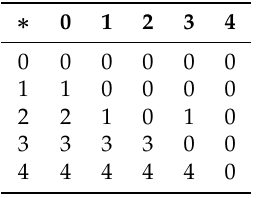
Table 3. Tabular representation of the binary operation ∗ .